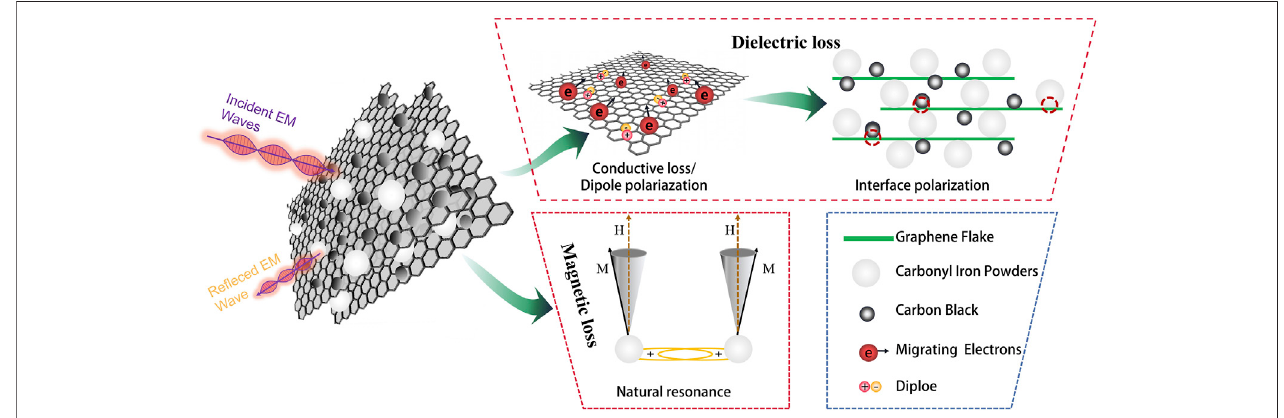
FIGURE 11 | Schematic illustration of mechanism in RGO-CB/CIP